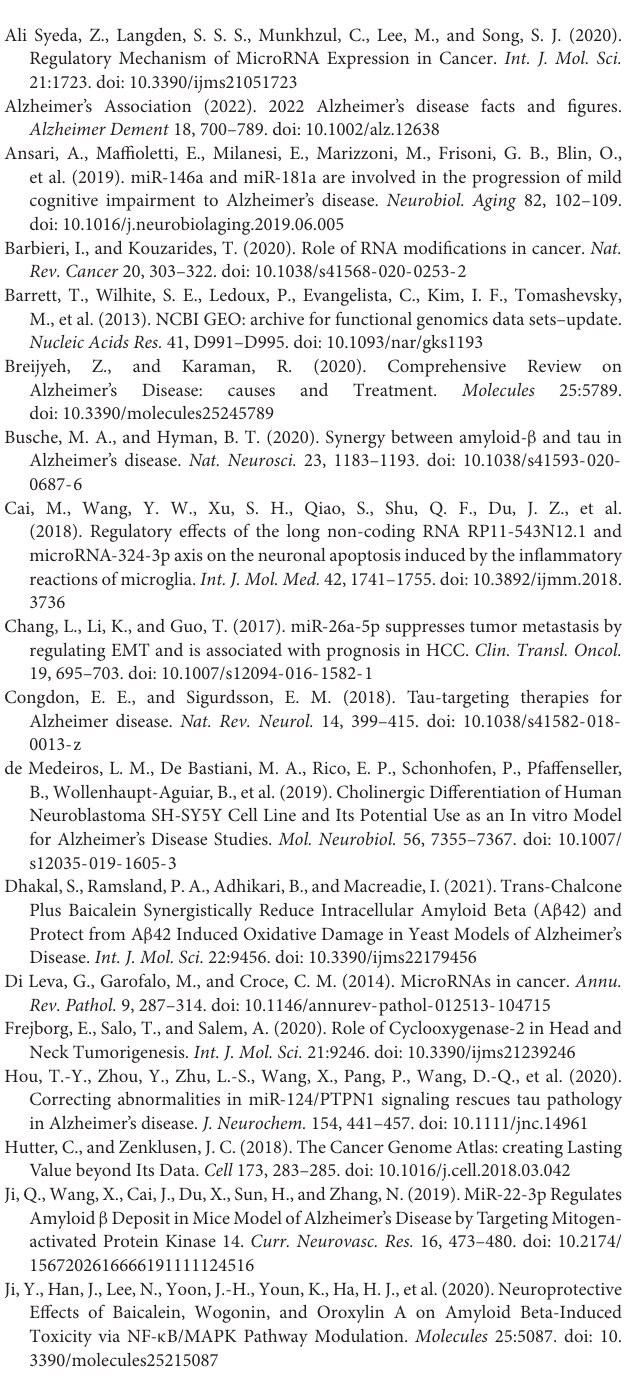
Supplementary Material 3 | AD related components in HUANGQIN from HERB database. AD, Alzheimer’s disease. Supplementary Material 4 | PTGS2 related components in HUANGQIN from HERB database. Supplementary Material 5 | The main components in HUANGQIN from TCMSP